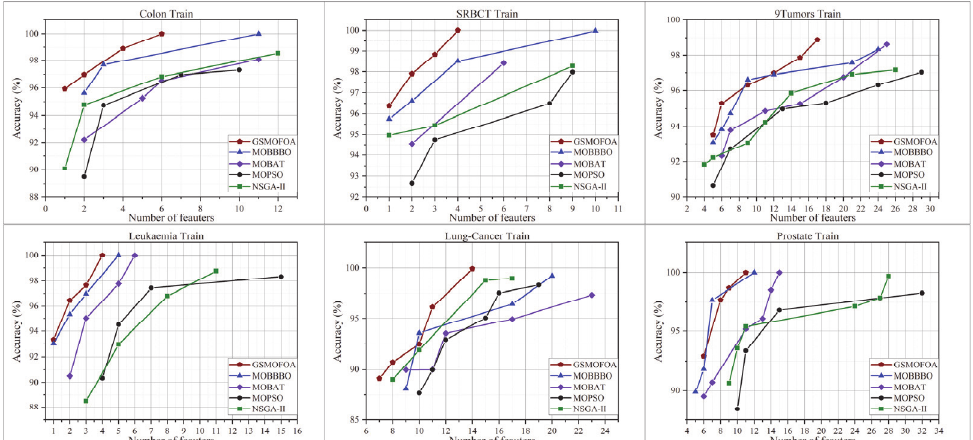
Fig. 7. A comparison between GSMOFOA ND solutions and other multi-objective algorithms on the train